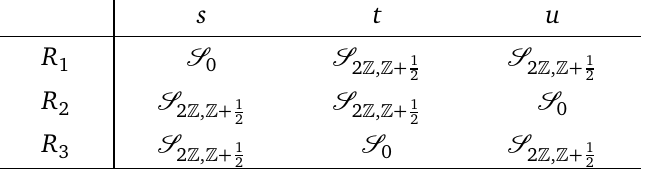
, R and R in each of the three 1 2 3